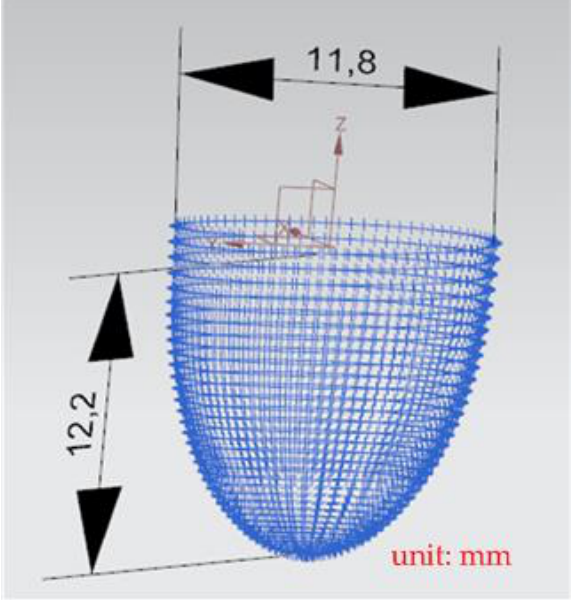
Figure 21. Spatial diagram of the converted concave circle rough machining.